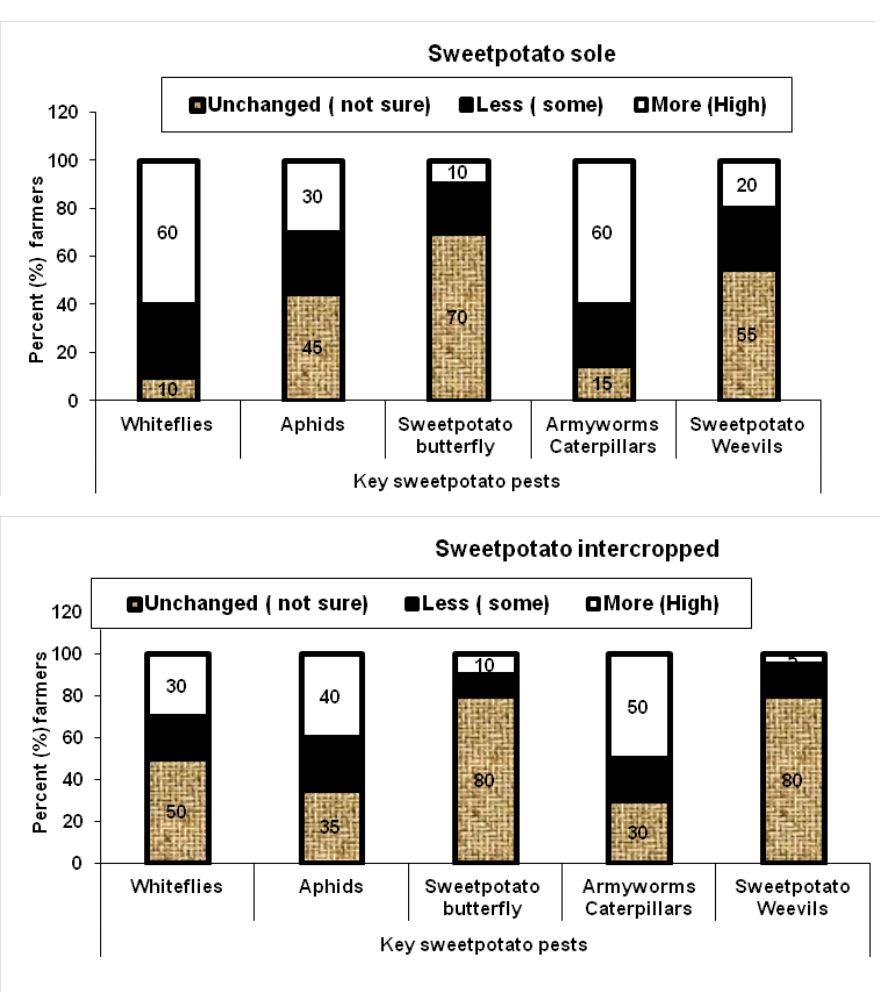
Figure 3b. Perception of farmers (%) reporting the change in the pest population density 10 years (2005-2015) ago as compared to the current situation (2015). These are perceived changes in abundance, pressure and damages caused by key pests to various sweet potato varieties. The perception is based on historical experience in struggling with sweet potato antagonists in the